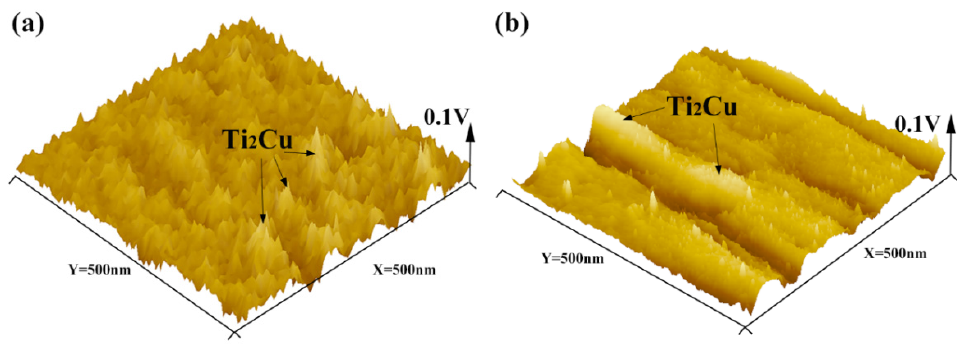
Figure 12. The 3D AFM images and surface potentials of the as-cast Ti-xCu alloys: ( a ) Ti-4Cu alloy, ( b ) Ti-10Cu alloy. ( b ) Ti-10Cu